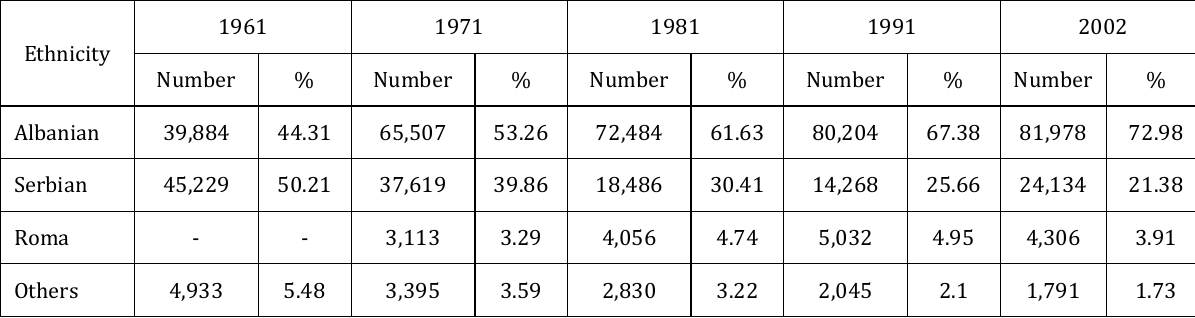
Table 1. Ethnic structure of the Presheva Valley for the period 1961–2002